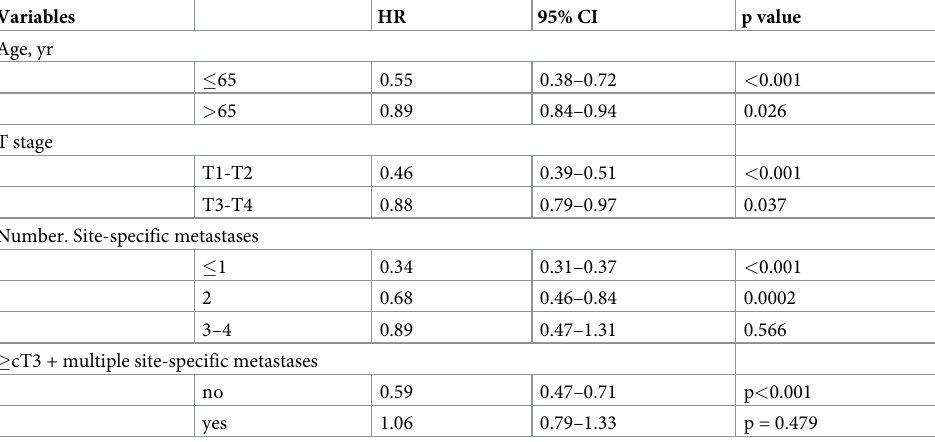
Table 3. Subset analyses of CSM in matched cohort between cytoreductive nephrectomy versus no surgery using univariate Cox proportional hazard model.